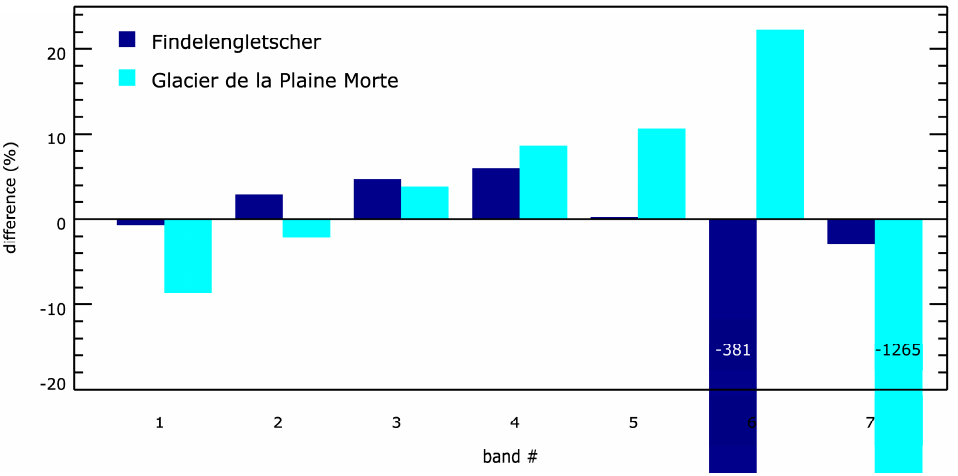
Figure A5. Average difference in percent before and after calibration of Landsat 8 scenes per individual band.